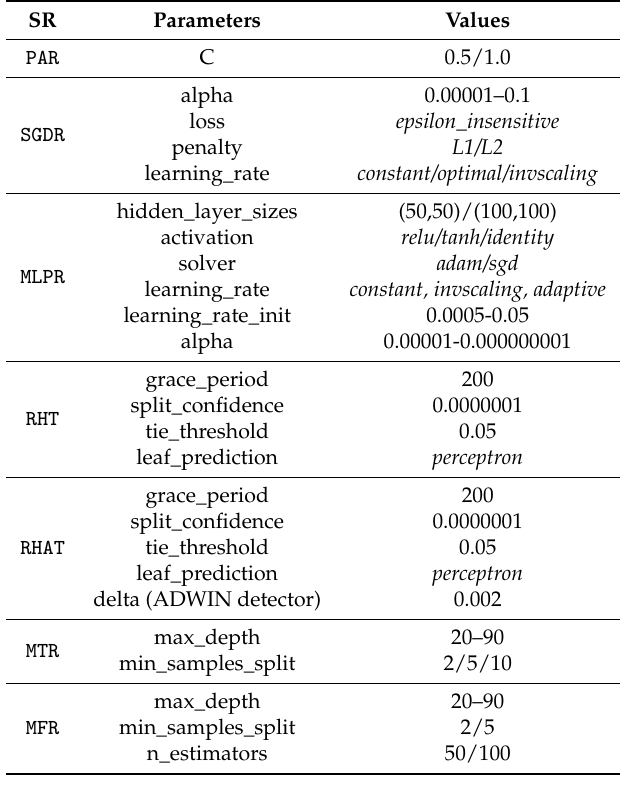
Table 9. Hyper-parameter tuning results for SRs in the experiment